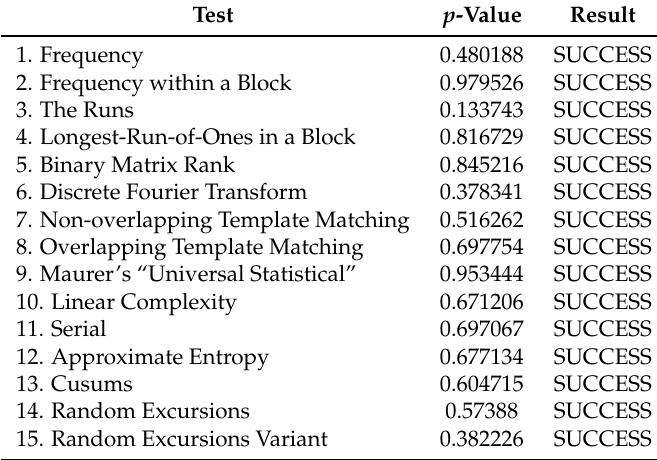
Table 2. Typical results when evaluating one sequence generated by Generador de Bits Pseudo Aleatorios (GBPA) using STS .